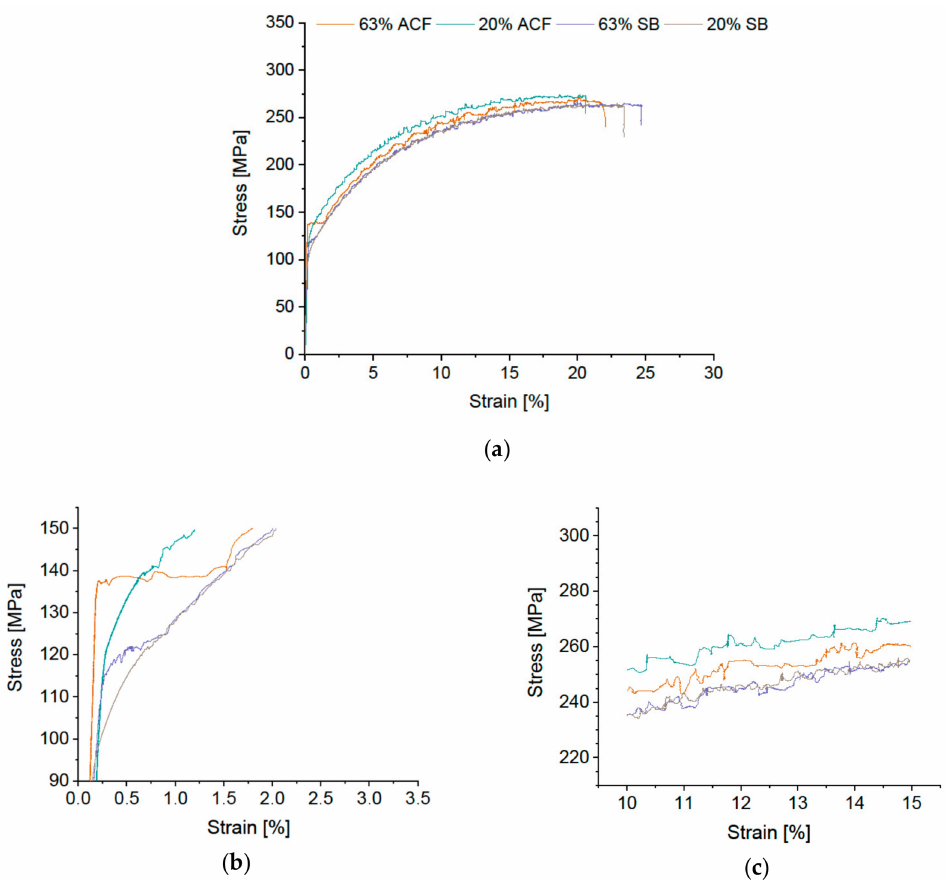
Figure 3. ( a ) Stress-strain diagram of standard EN AW-5182 with cold-rolling degrees of 63% and 20%, soft annealing in air-circulated furnace (ACF) at 370 ◦ C and fast salt-bath (SB) heat treatment at 500 ◦ C with subsequent water quenching. Details of ( b ) Lüders elongation and ( c ) the sector 10–15% elongation to depict stress serrations due to dynamic strain